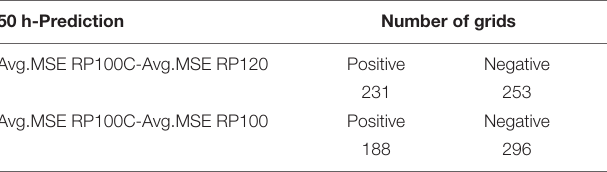
TABLE 4 | Sign of MSE difference between PCA-FCM clustered 100 events, original 120 events, and the randomly clustered 100